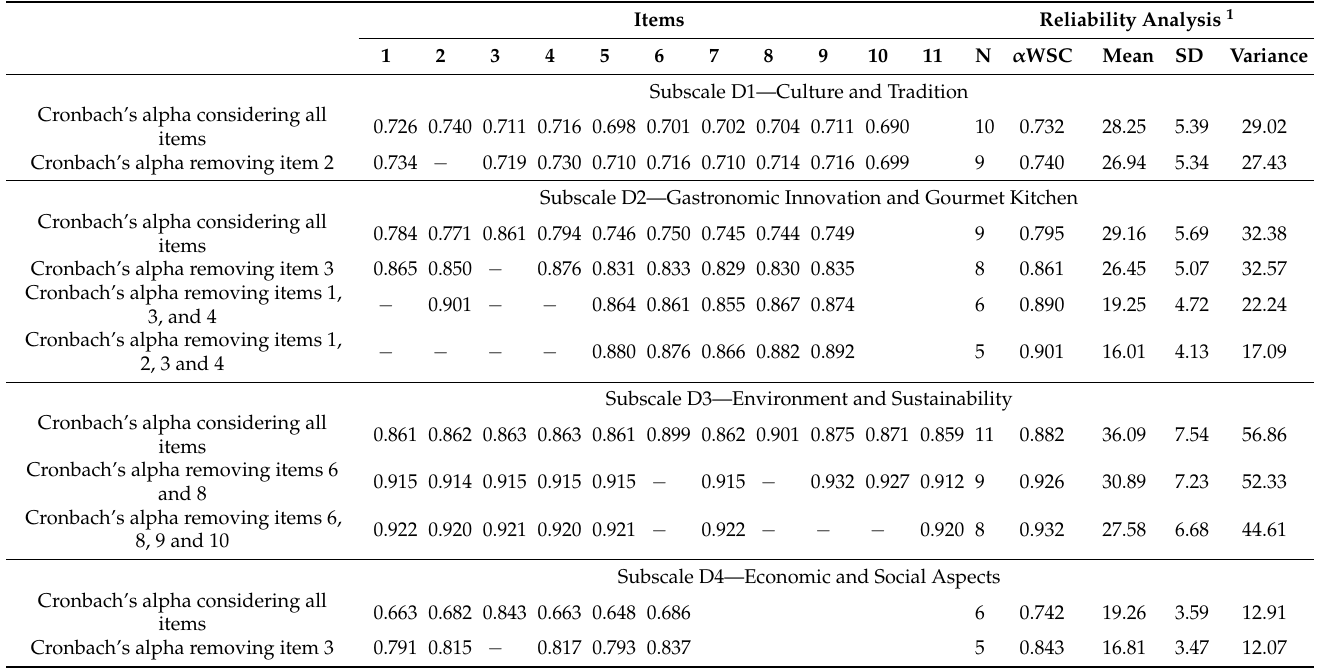
Table 2. Internal reliability analysis of all seven